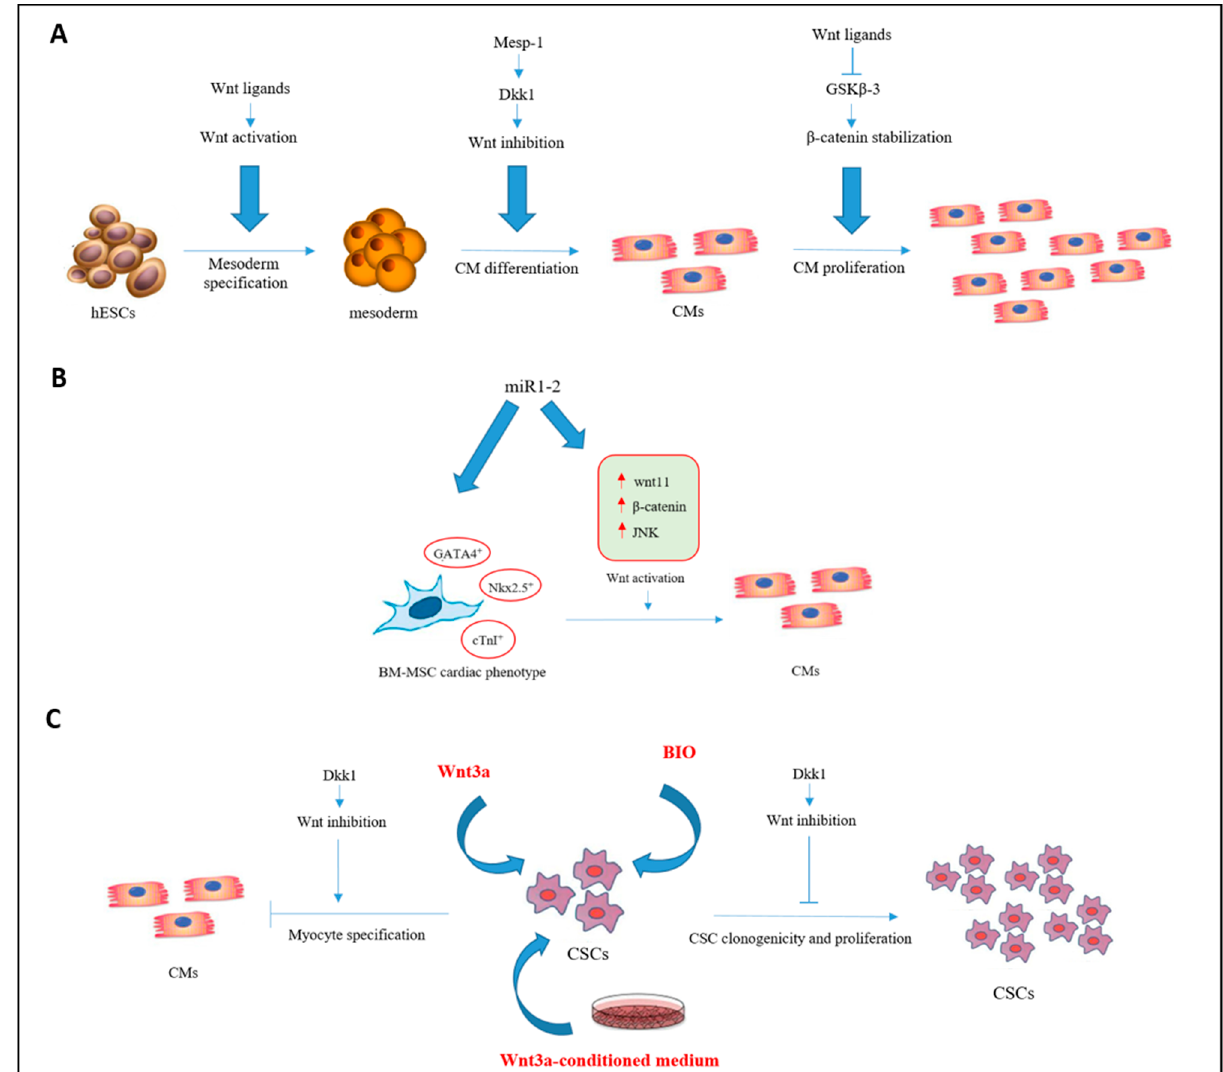
Figure 2. The biphasic role of wnt/ β -catenin pathway in heart muscle development. ( A ) Wnt/ β -catenin pathway promotes mesoderm specification in the early stages of hESC differentiation, while, its activation inhibits CM differentiation in the later stages. The cardiac differentiation inducer Mesp1 activates the inhibitor of canonical wnts, Dkk1, promoting CM differentiation. Moreover, the presence of wnt ligands inhibit GSK3 β and lead to β -catenin stabilization in the cytoplasm and its traslocation into the nucleus promoting CM proliferation. ( B ) The overexpression of miR1-2 induces the expression of cardiac specific genes BM-MSCs and activates the wnt/ β -catenin signaling pathway promoting their cardiac differentiation. ( C ) Wnt-3a, wnt-3a-conditioned medium and BIO stimulate CSC proliferation and clonogenicity, while, significantly inhibit CSC differentiation into myocyte-committed cells. In contrast, Dkk1 decreases CSC proliferation and clonogenicity and promotes myocyte specification, through the inhibition of the canonical wnt pathway. hESCs: human Embrionic Stem Cells; CMs: Cardiomyocytes; Dkk-1: Dickkopf-related protein 1; GSK3- β : Glycogen synthase kinase 3- β ; BM-MSCs: Bone Marrow derived Mesenchimal Stem Cells; Nkx2.5: NK2 transcription factor related locus 5; cTnI: cardiac Troponin I; CSCs: Cardiac Stem Cells; JNK: c-Jun N-terminal kinase; BIO: bromoindirubin-3 ′ -oxime; ↑ increase.